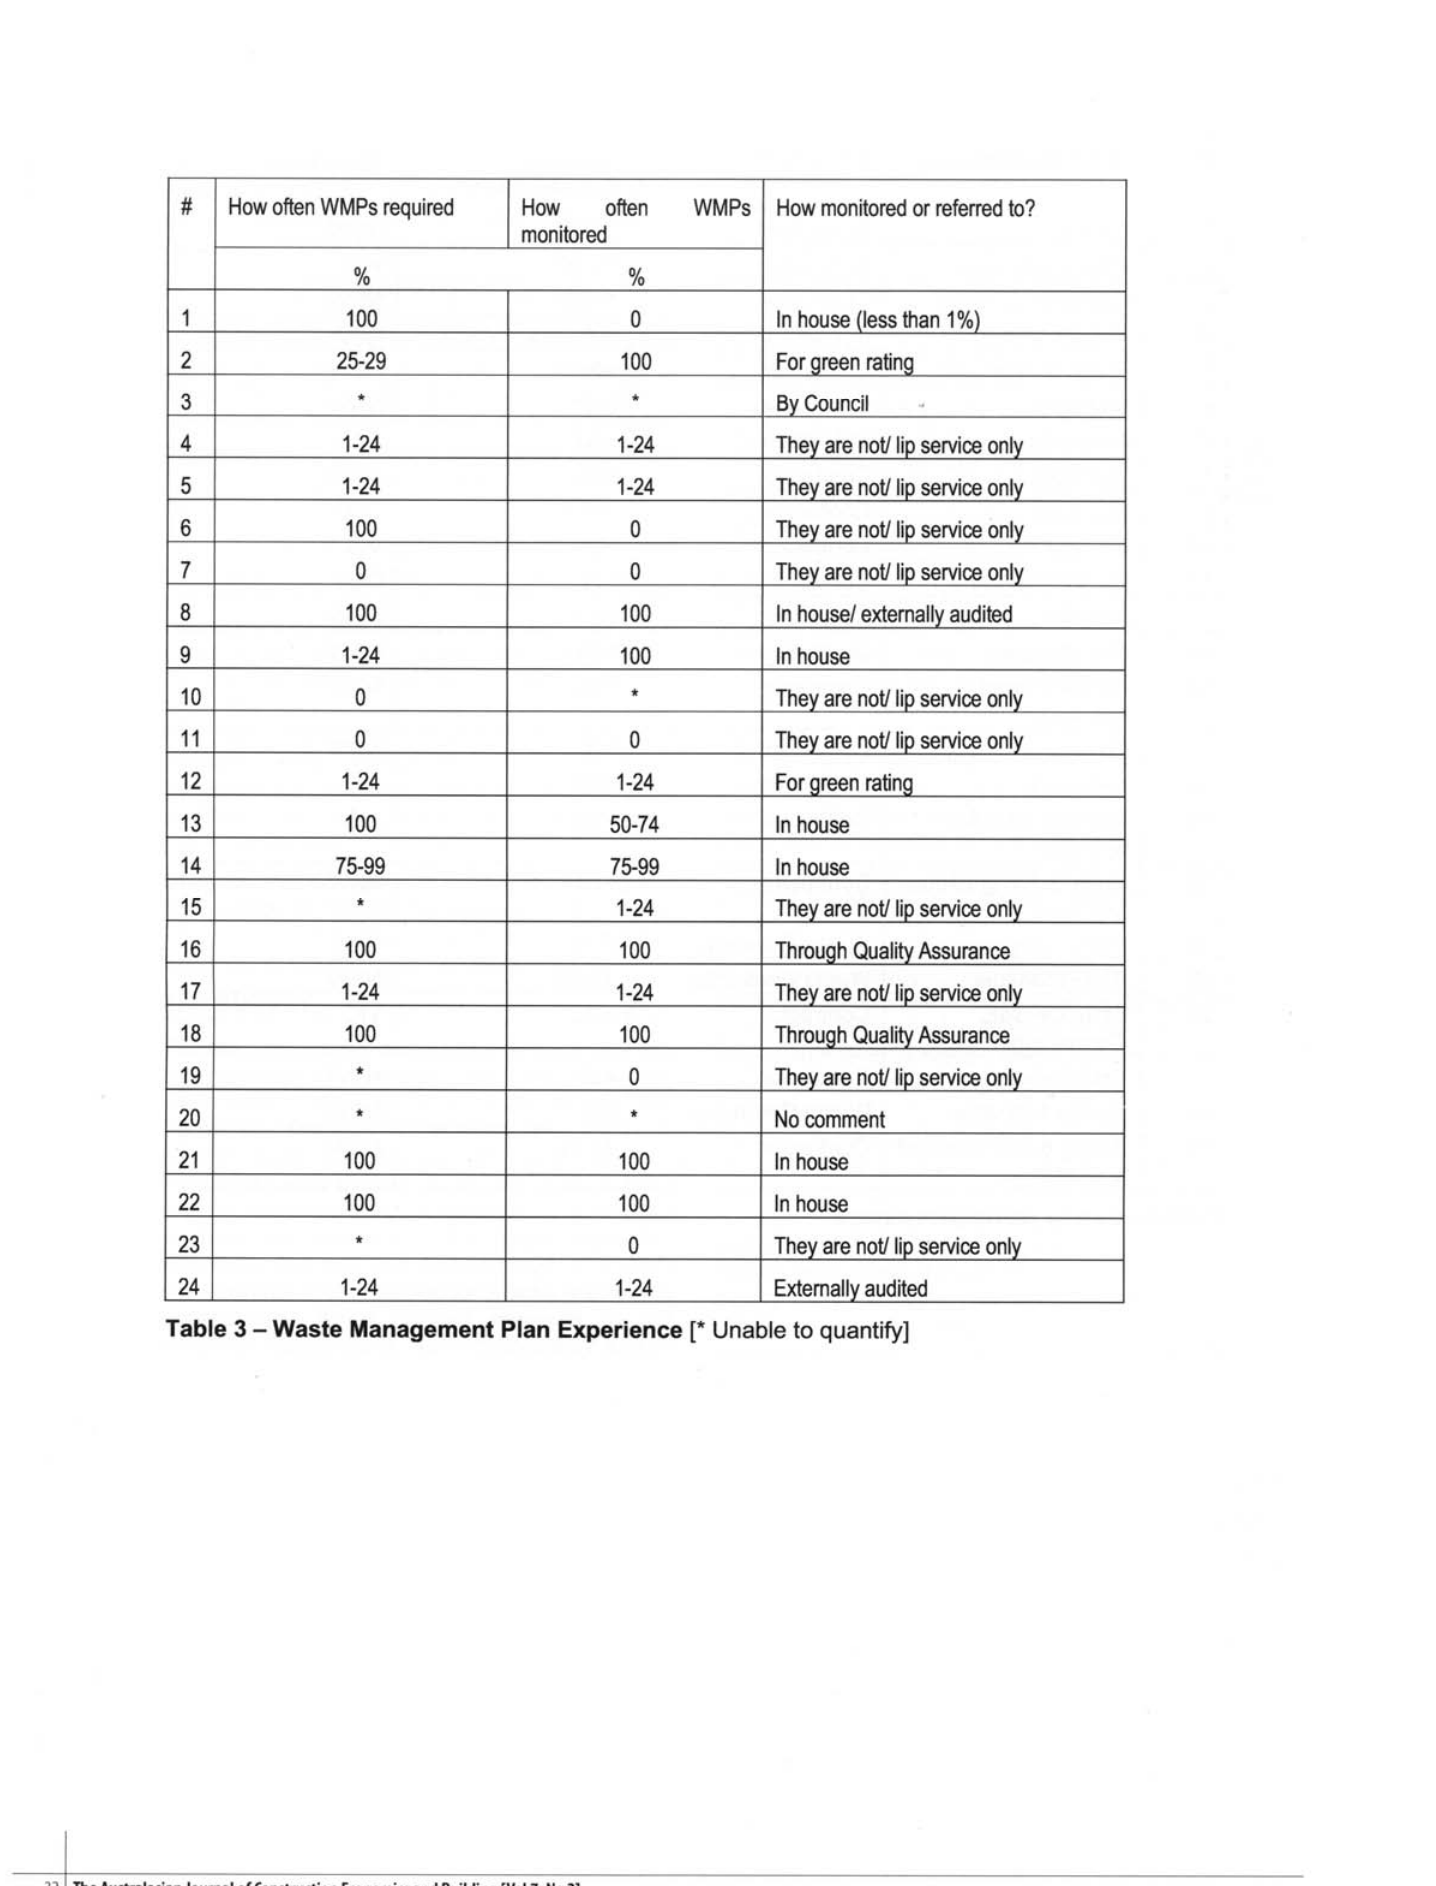
Table 3 - Waste Management Plan Experience [* Unable to